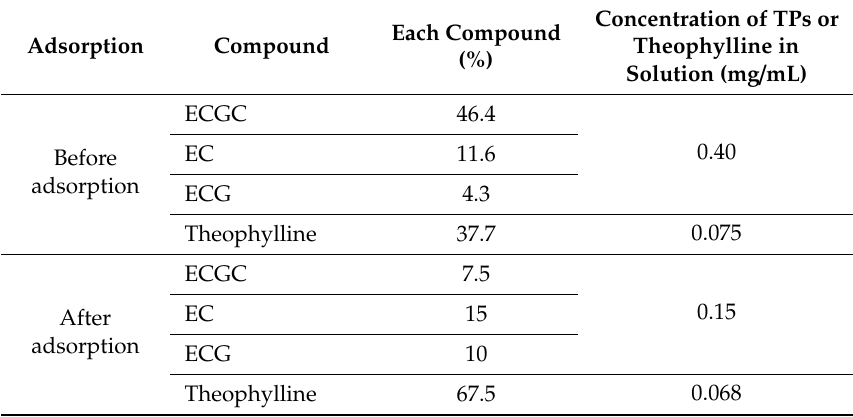
Table 4. Compounds in the tea solution before and after adsorption.